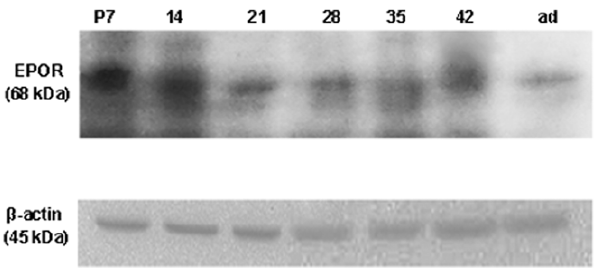
Figure 3. Immunoblot analysis of EPOR in mouse kidney cortex during the development. The position of 68 kDa molecular size was the expression pattern of EPOR in renal cortex at the indicated ages. b - actin was used as a consult. When the expression of EPOR was normalized to b -actin, the level was found decreased with develop-